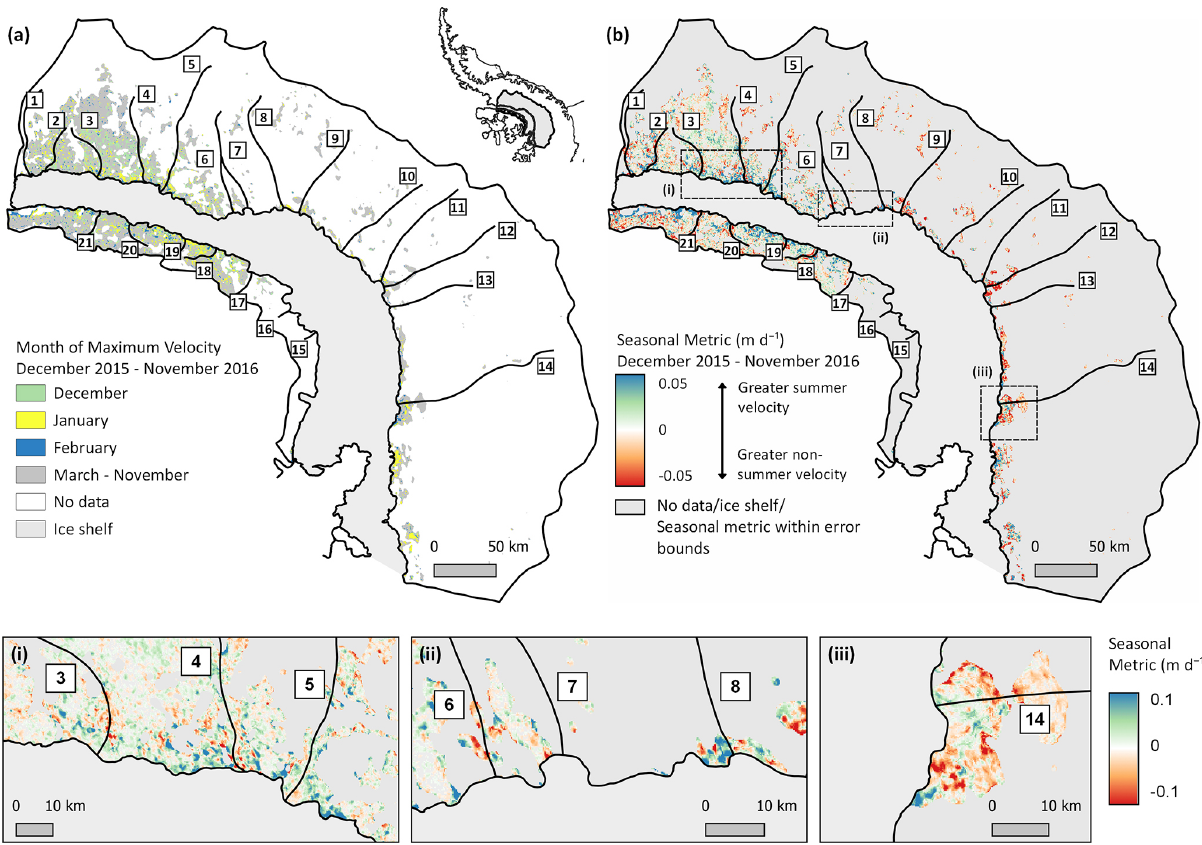
Figure B2. Same as Fig. 3 but showing spatially resolved patterns of seasonal ice flow as observed between December 2015 and Novem- ber 2016. Panel (a) shows the month of maximum velocity ( v time ) and (b) the calculated velocity anomaly ( v anom velocity anomalies (blue) indicate summertime speed-up and negative (red) greater velocity during non-summertime months. Dashed boxes denote the location of the inset boxes (i–iii). See also Figs. B1,